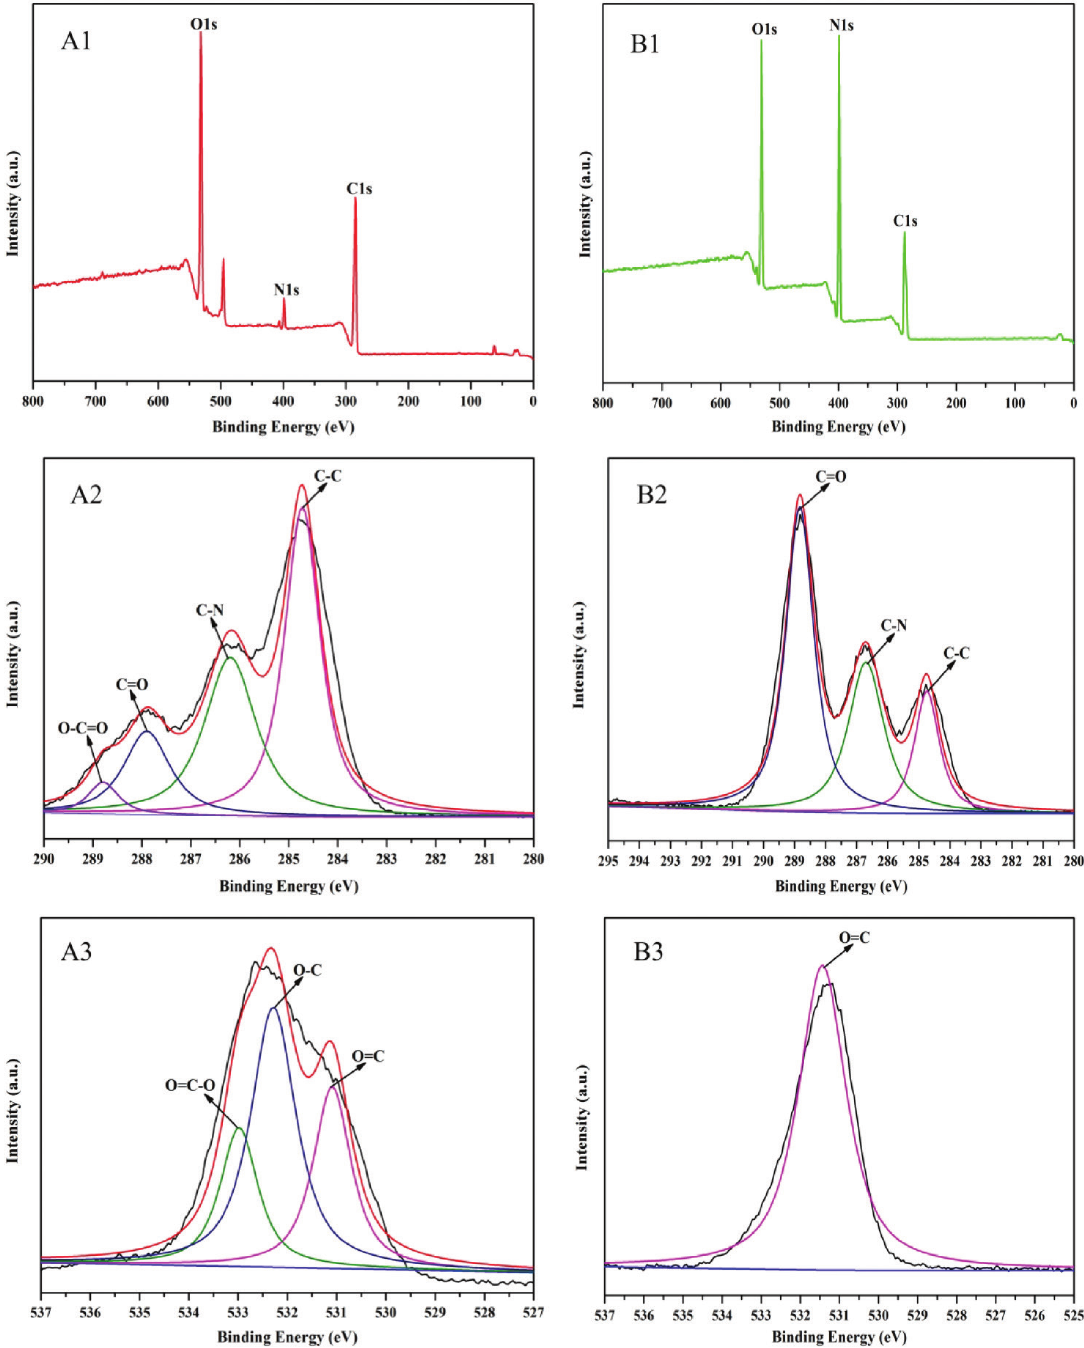
Figure 3: XPS survey spectra of SC-g-PAA/PAM/Urea (A1) and urea (B1), C1s of SC-g-PAA/PAM/Urea (A2), C1s of urea (B2), O1s of SC-g-PAA/ PAM/Urea (A3), O1s of urea